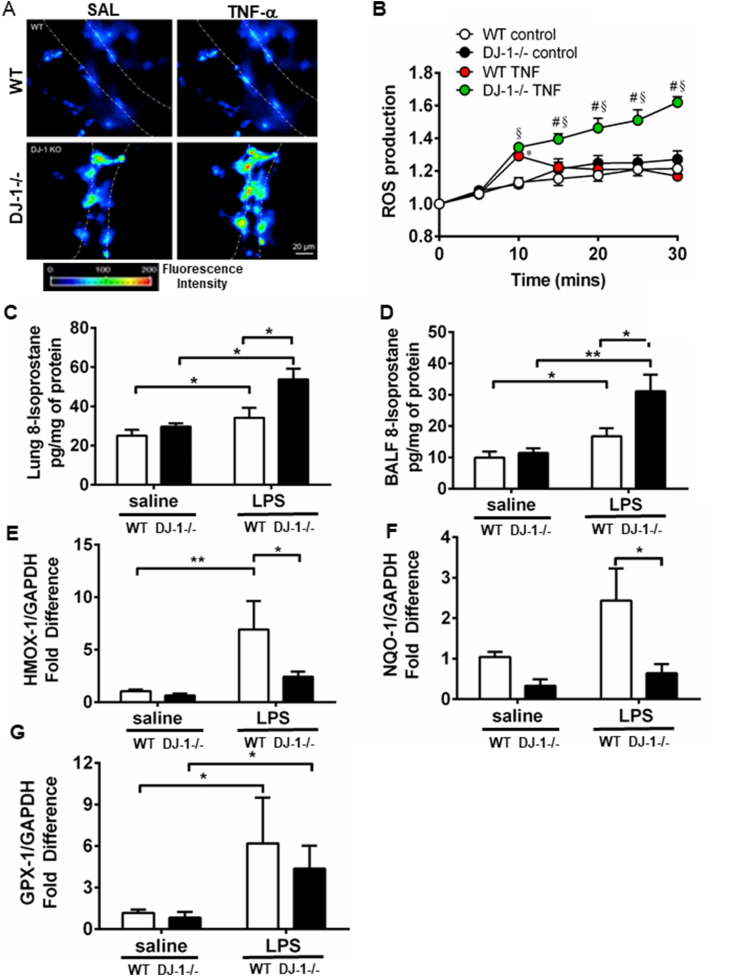
Loss of DJ-1 aggravates pulmonary oxidative stress following LPS stimulation. A) Representative images of H2DCFDA-loaded endothelial cells in micro-vessels of the isolated perfused mouse lung showing imaging of endothelial DCF with increasing fluorescence intensity in the DJ-1−/− B) and quantitative analysis of DCF fluorescence relative to baseline showing increased ROS production in response to TNF-α infusion (1000 U/mL) in DJ-1−/− compared to WT lungs. Data are presented as means ± SEM (n = 3–5 mice per group, *p < 0.05 compared to WT saline and #p < 0.05 compared to WT TNF treated). 8-Isoprostane levels in C) lung lysates and D) BALF in WT and DJ-1−/− animals following LPS instillation. Bar graphs represent means ± SEM (n = 7–9 per group, *p ≤ 0.05, **p ≤ 0.01, two-way ANOVA). Real-time PCR analysis of E) HMOX-1, F) NQO-1 and G) GPX-1 mRNA levels in WT and DJ-1−/− lungs 24 h following LPS instillation. Bar graphs represent means ± SEM (n = 6–8 per group, *p ≤ 0.05, **p ≤ 0.01, two-way ANOVA).